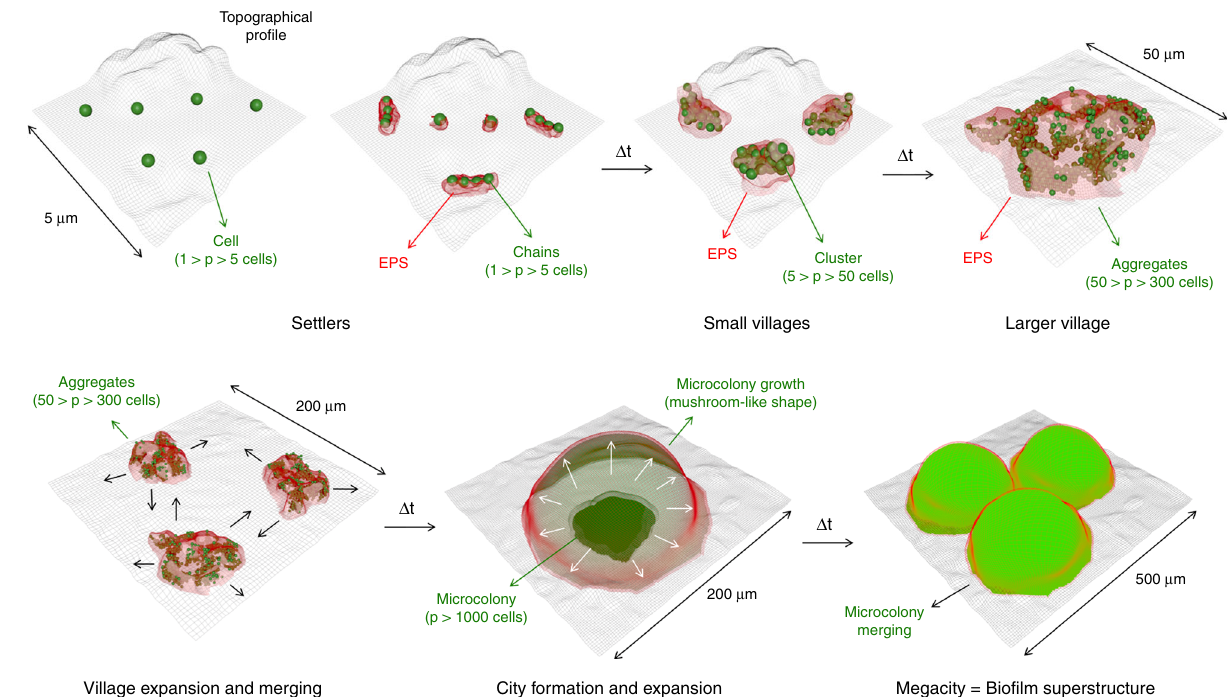
Fig. 8 Schematic diagram of spatiotemporal population growth during bio fi lm development. Dynamics of bacterial population growth during bio fi lm development resemble spatial and structural aspects of